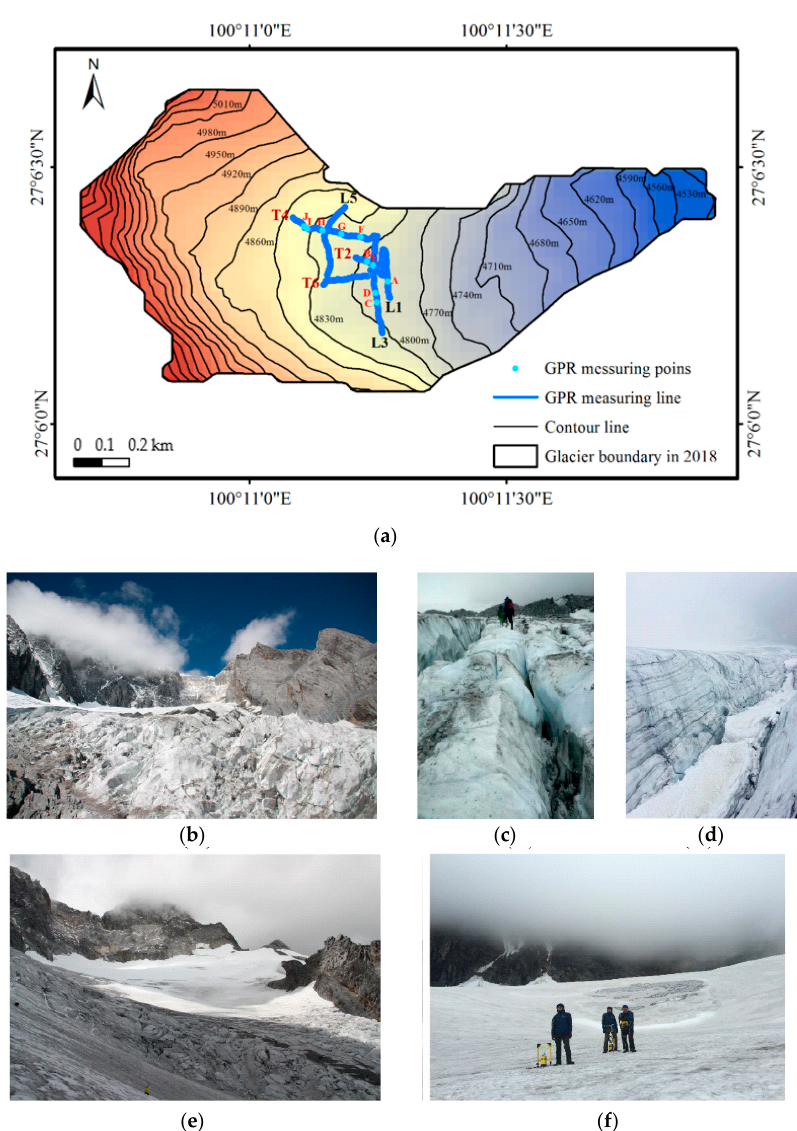
Figure 2. ( a ) The ground-penetrating radar (GPR) measuring network of the Baishui River Glacier No. 1 (BRG1) at Mt. Yulong in 2018. ( b ) Ice towers at 4500 m a.s.l. ( c ) Glacier crevasse at 4700 m